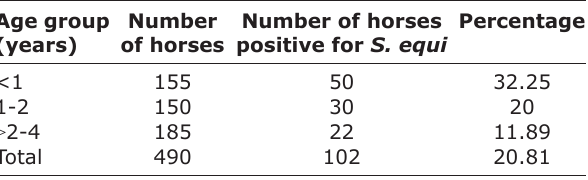
Table-1: Prevalence of strangles in different age groups of Arabian